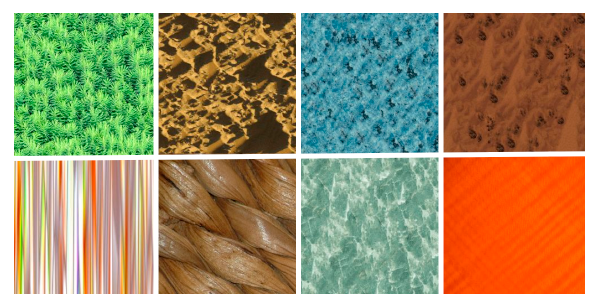
Figure 1. Example textures, used in the experiment. Both computer-generated and natural textures were used, and the set included both colored and gray- scaled